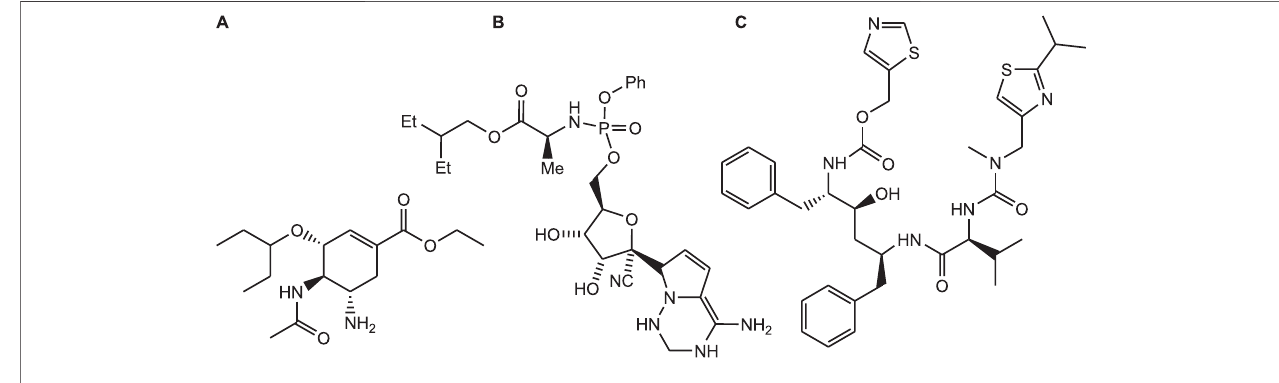
FIGURE 2 | Structure of oseltamivir (A) , remdesivir (B) and ritonavir (C) .